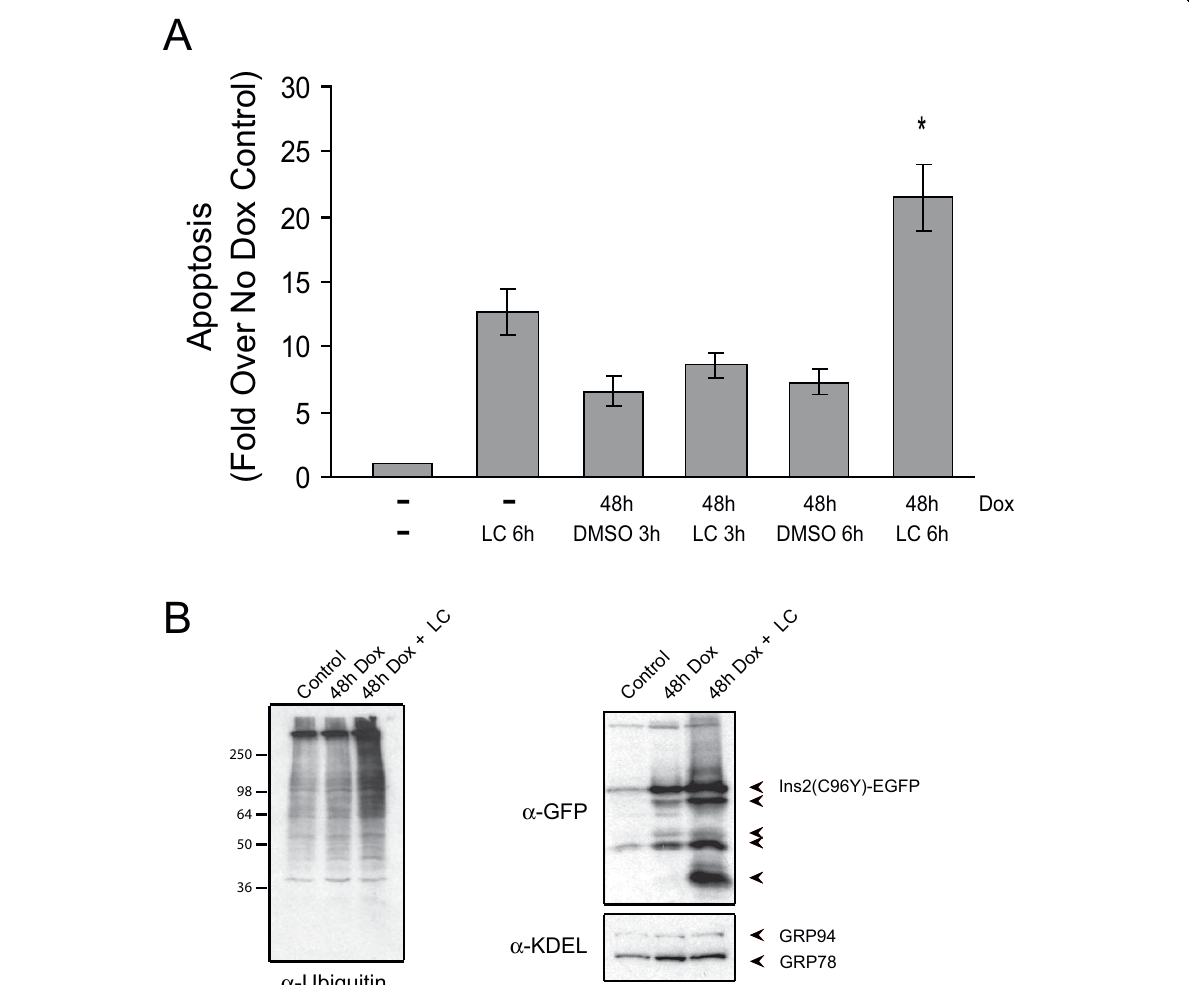
Figure 8 The proteasome inhibitor lactacystin increases susceptibility of the mutant insulin expressing clone to apoptosis . A . Clone #4S2 cells were untreated or treated with 2 μ g/ml doxycycline for 48 h. Cells were then untreated or treated with 10 μ M of lactacystin (LC) or an equivalent volume of DMSO for the times indicated. Apoptosis was measured using a cell death detection ELISA kit as described in the Methods. Shown are the mean ± SE of 3 independent experiments. *p < 0.05. B . Following 42 h of doxycycline treatment, cells were untreated, or treated with 10 μ M of lactacystin (LC) or an equivalent volume of DMSO for 6 h in the presence of doxycycline. The cells were washed in PBS and lysed. Cell lysates (left panel) or TX-100 insoluble material (right panel) were resolved by SDS-PAGE and immunoblotted using the indicated antibodies. Note the increase in the levels of degradation products detected by the GFP antibody with LC treatment